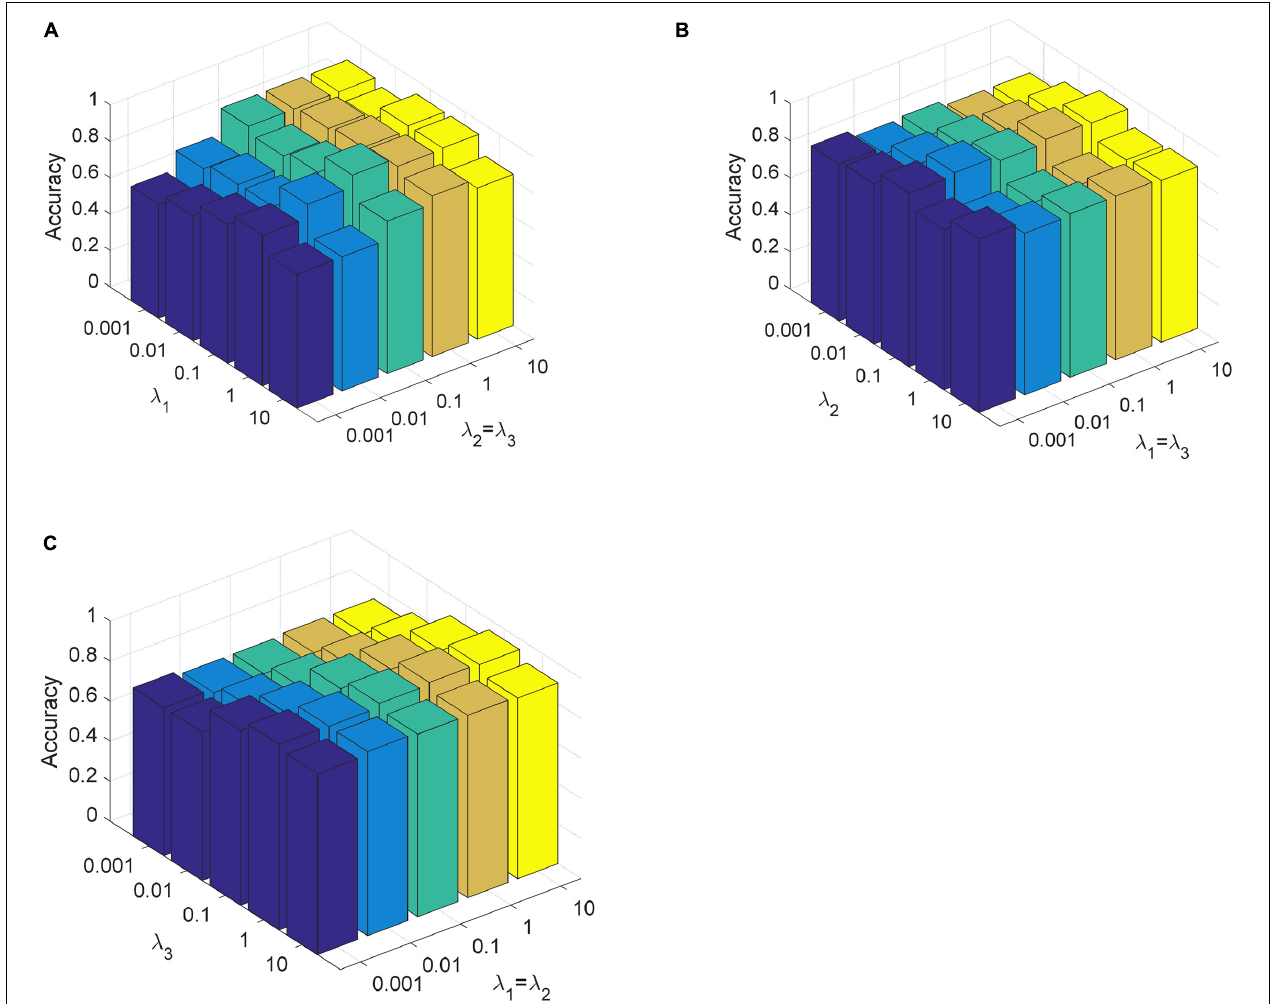
and λ ( λ ), (B) λ 1 2 3